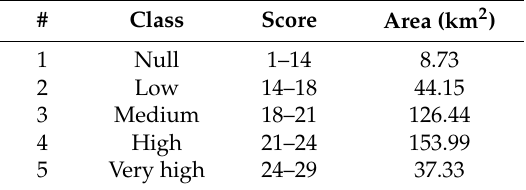
Table 9. Classes of landslide proneness and their spatial distribution in the Entella River catchment